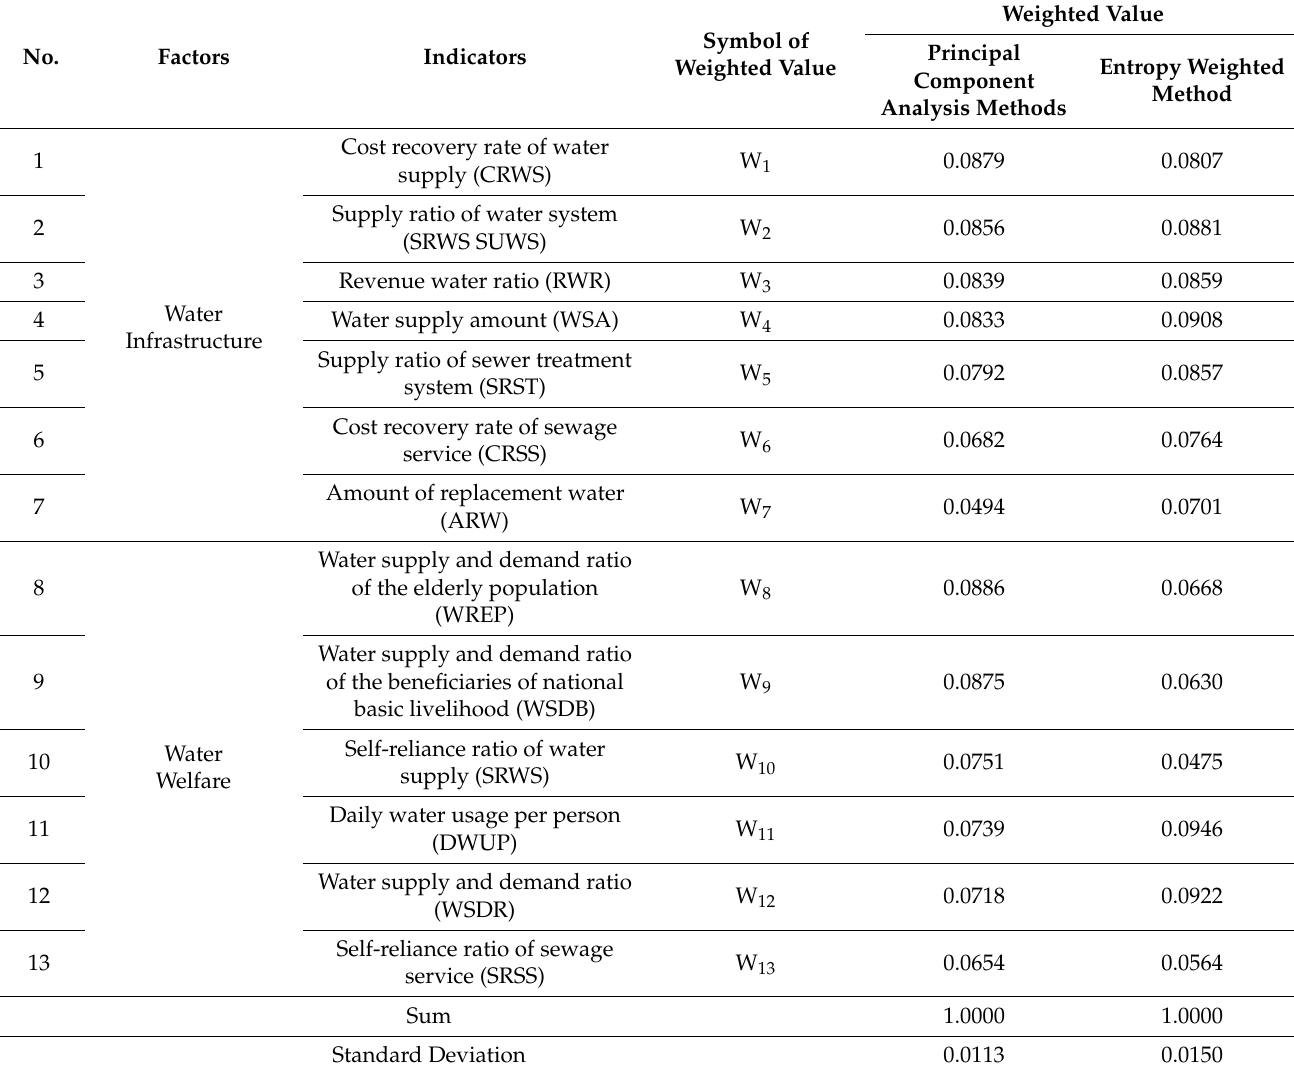
Table 9. Results of the weighted value for the detailed